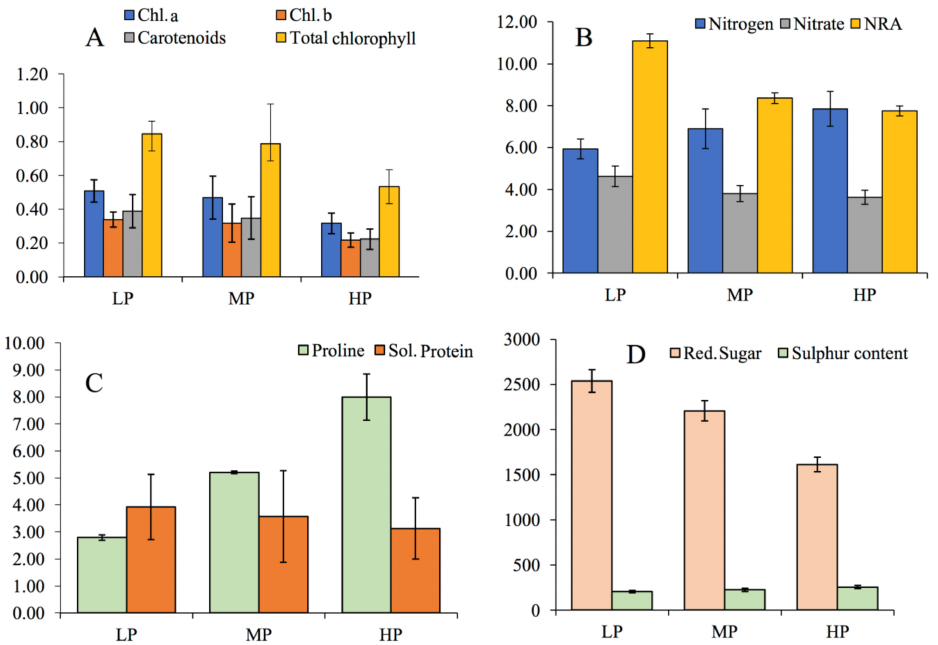
Figure 1. Variation in the biochemical parameters of P. dulce at three di ff erent sites ( A ) Chl. A, Chl. b , carotenoids, total chlorophyll (mg g − 1 fw) ( B ) Nitrate and NRA (mmolg − 1 fw) ( C ) protein (mg g -1 fw) and proline ( µ g g − 1 fw) ( D ) Sulphur (mg g − 1 dw) and reducing sugar (mg g − 1 fw). Data represents mean ± SD ( n =